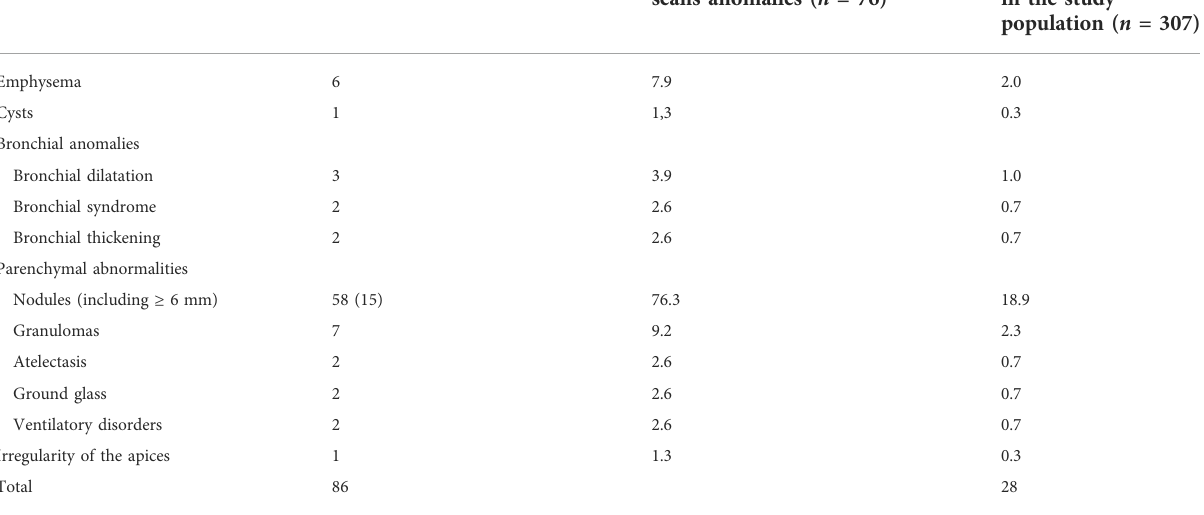
TABLE 2 Prevalence of abnormalities found on chest CT